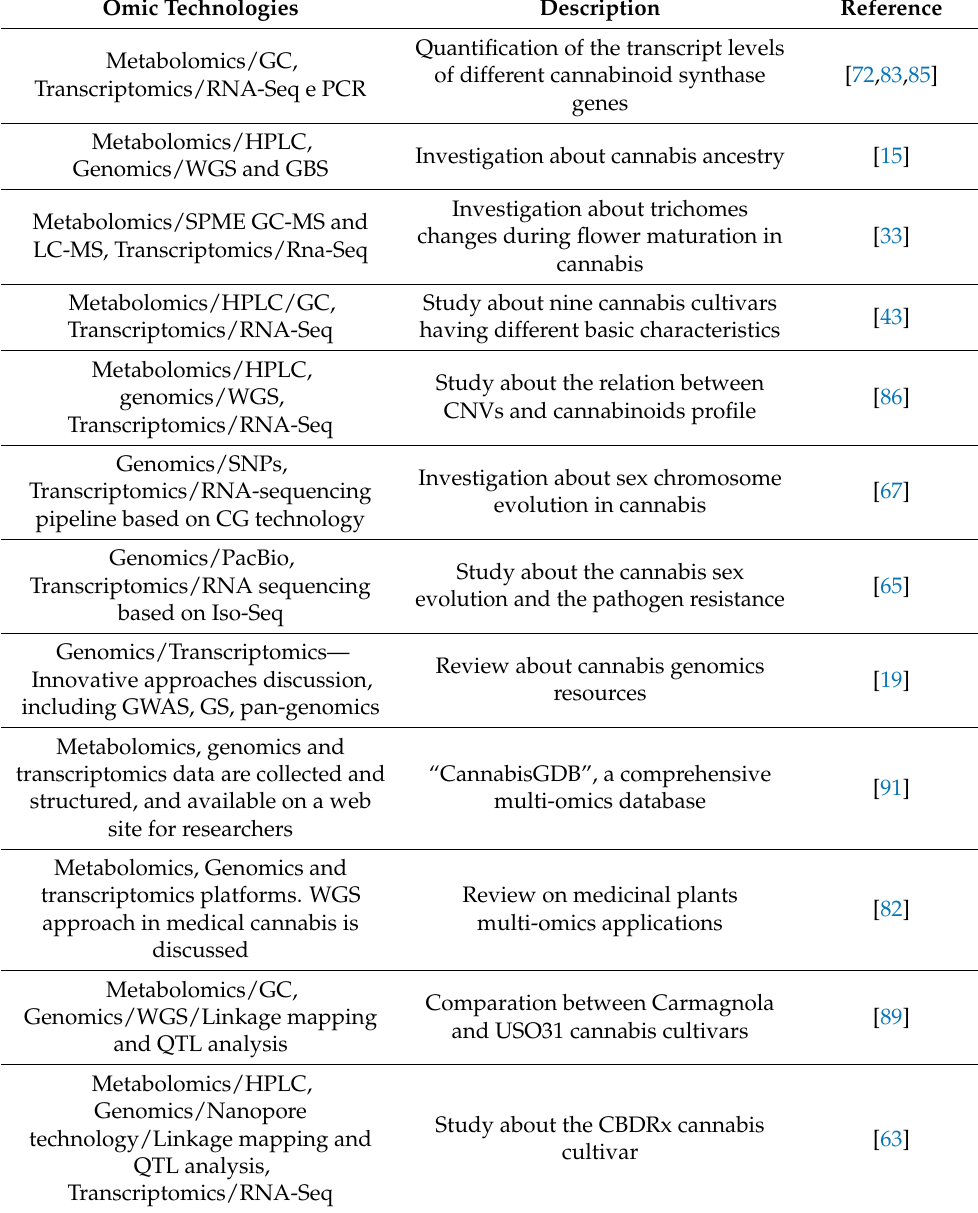
Table 3. The multi-omic studies examined in this